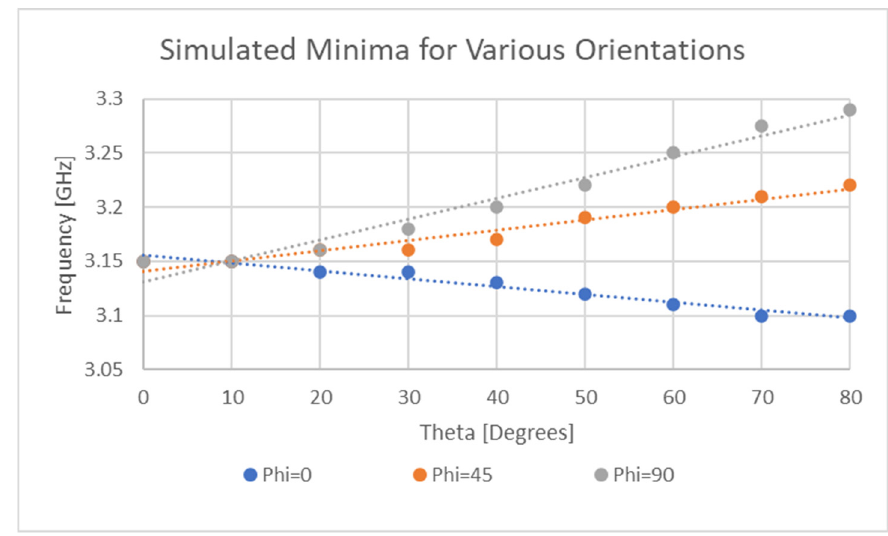
Figure 23. Orientation sensitivity of sensor resonant response.